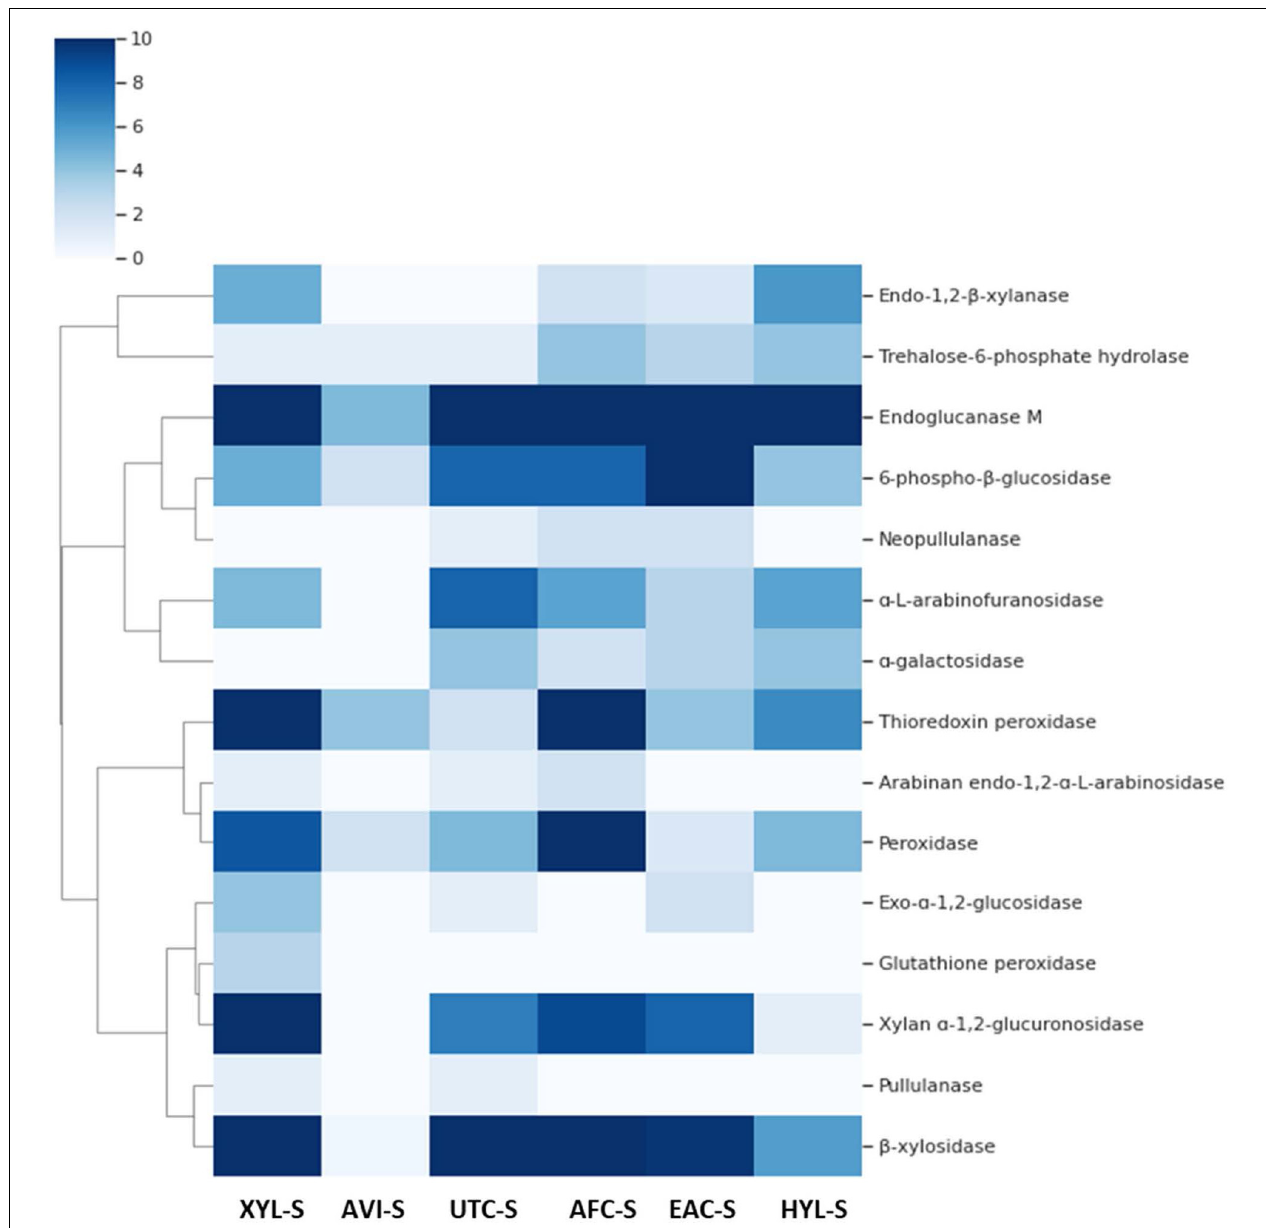
FIGURE 4 | Heat map of spectral counts of different enzymes such as cellulases, hemicellulases, and peroxidases present in secretomes of Geobacillus sp. WSUCF1 bacterial strain. Each row represents an enzyme, and each column represents secretome producing using different substrates given in bracket: XYL-S (Xylan), AVI-S (Avicel), UTC-S (UT-CS), AFC-S (AFEX-CS), EAC-S (EA-CS), and HYL-S (AFEX-CS Hydrolysate). The cells with the darker turquoise color had the higher spectral count showing a higher concentration of enzymes and lightly colored cells had a lower spectral count with lower enzyme concentration. The dendrogram on the left side of the heatmap clusters the enzymes that have similar spectral counts across all